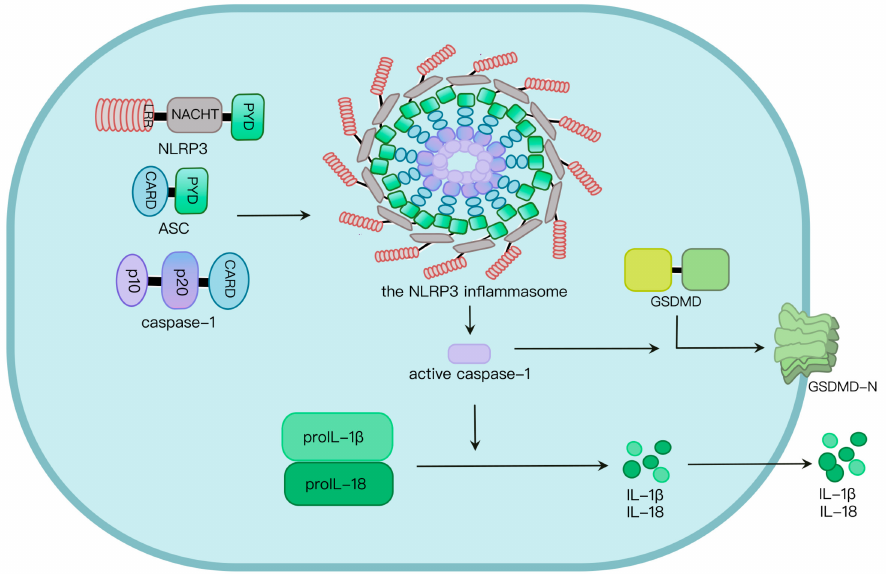
Figure 1. NLRP3 inflammasome activation. NLRP3, along with ASC, induces caspase-1 activation via assembly of the NLRP3 inflammasome upon challenges. Caspase-1 activation leads to maturation and secretion of proinflammatory cytokines such as IL-1 β and IL-18, as well as programmed cell death called pyroptosis induced by GSDMD pores in the plasma